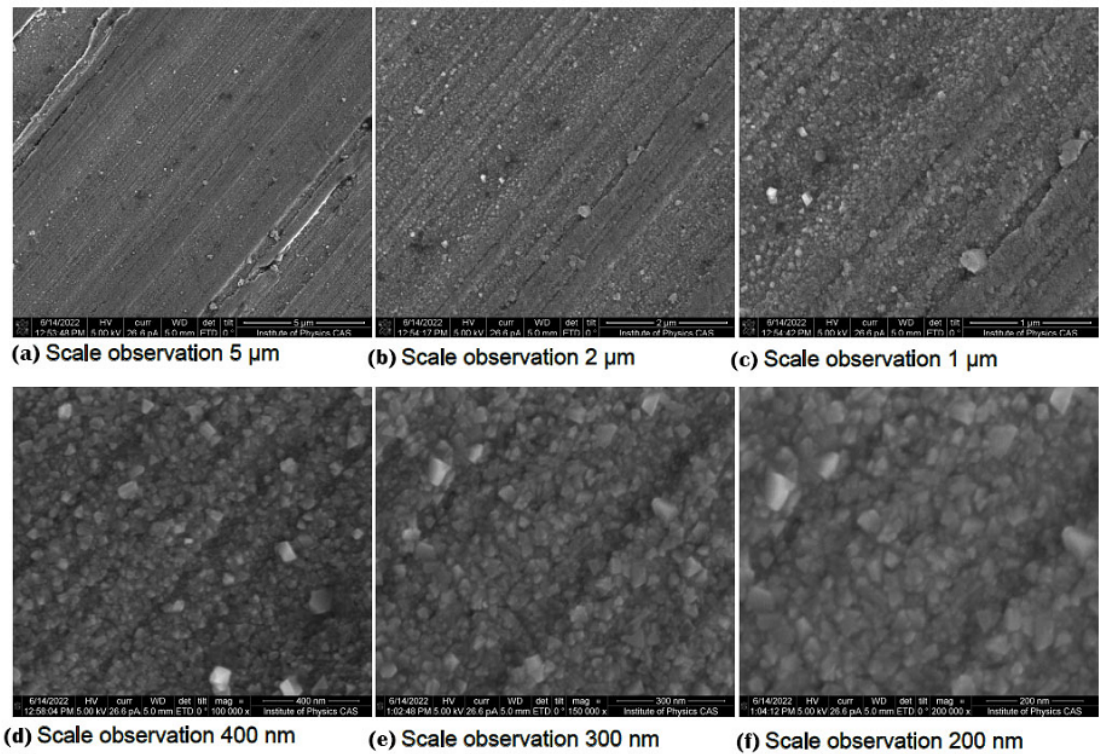
Figure 13. FEG-SEM images of surface layer oxide crystals of untreated specimen, images ( a – f ) at gradually increasing magnifications.